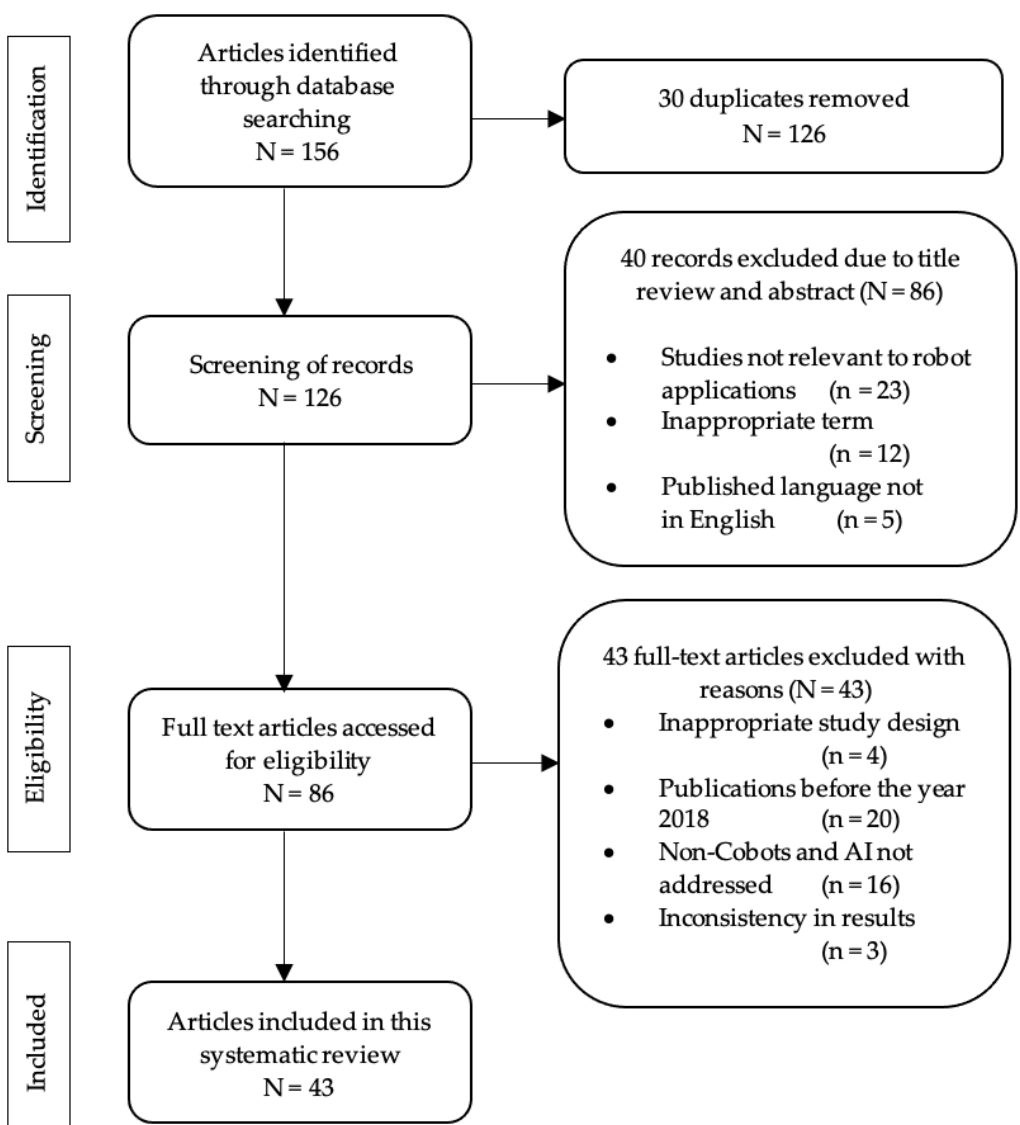
Figure 3. The PRISMA model diagram for the systematic review.